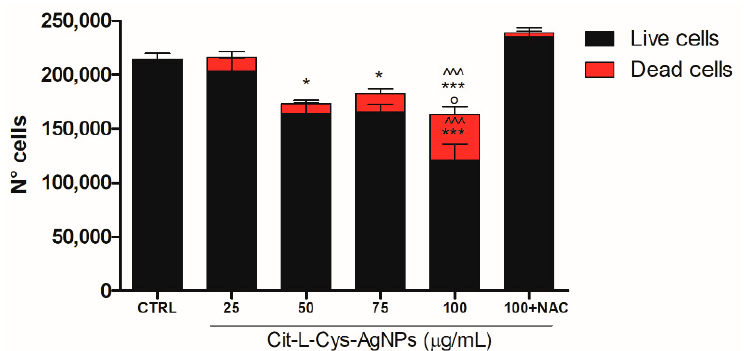
Figure 11. Effect of AgNPs/L-cys/citr on HEK293T cells counting. Number of live and dead cells after 24h from treatments with cit-L-cys-AgNPs (25-50-75-100 µ g/mL) and AgNPs/L-cys/citr (100 µ g/mL) + NAC (2 mM). Live cells: * p < 0.05 vs. CTRL; *** p < 0.001 vs. CTRL; ˆˆˆ p < 0.001 vs. 100 + NAC; ◦ p < 0.05 vs. 75 µ g/mL and 50 µ g/mL. Dead cells: *** p < 0.001 vs. CTRL; ˆˆˆ p < 0.001 vs. 100 + NAC.